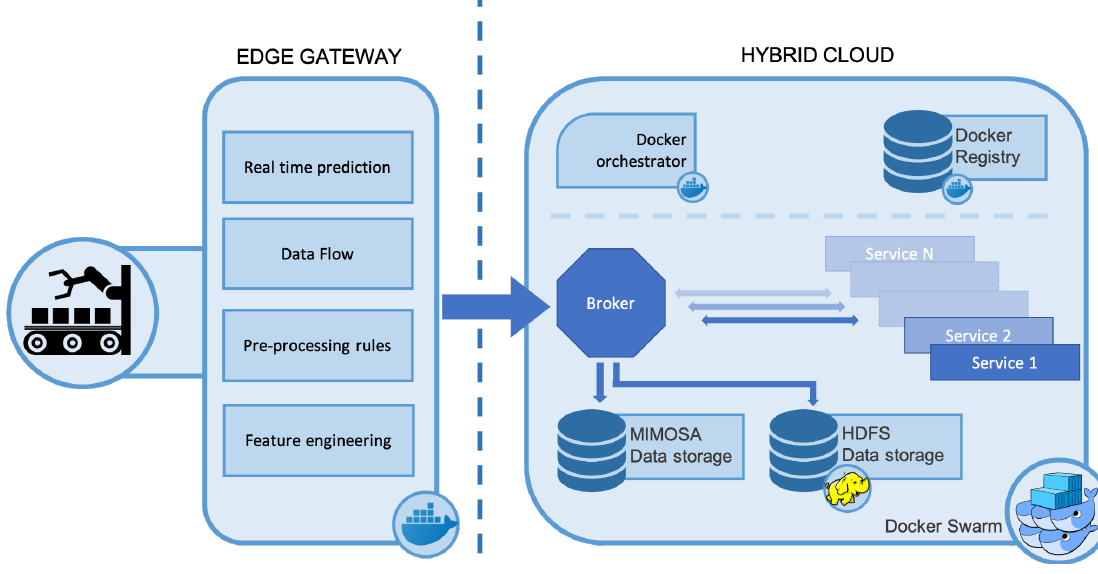
Figure 1. The SERENA